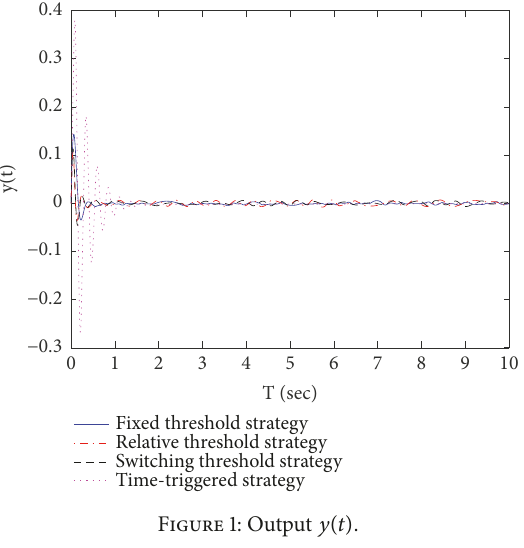
Figure 1: Output 𝑦(𝑡) .